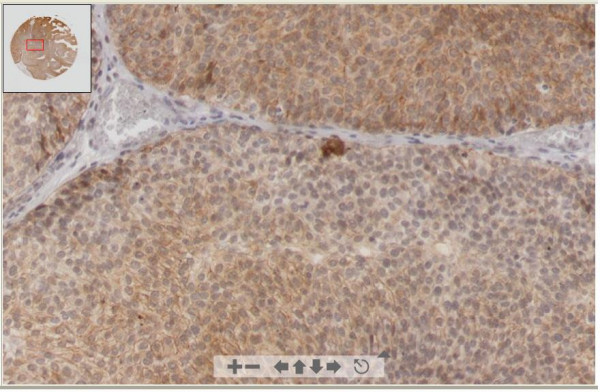
Digital image of TMA spot presented in VTM using Zoomify™ application. On the top left corner of image is the thumbnail overview; the red box identifies location within the spot. The key at the bottom of the image allows the user to change position or magnification, which can also be controlled by the cursor.